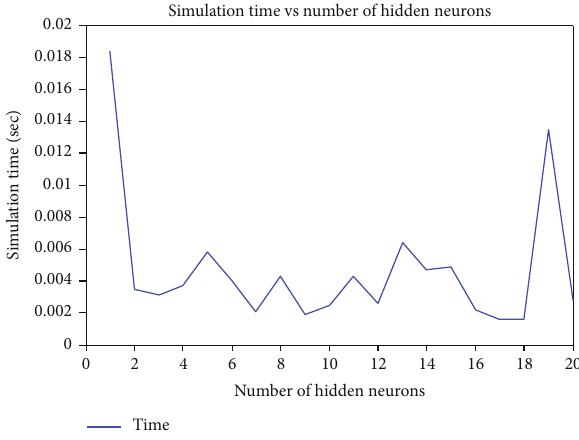
Figure 7: Two input MLPNN-based forecasting model simulation times vs. the number of hidden neurons.